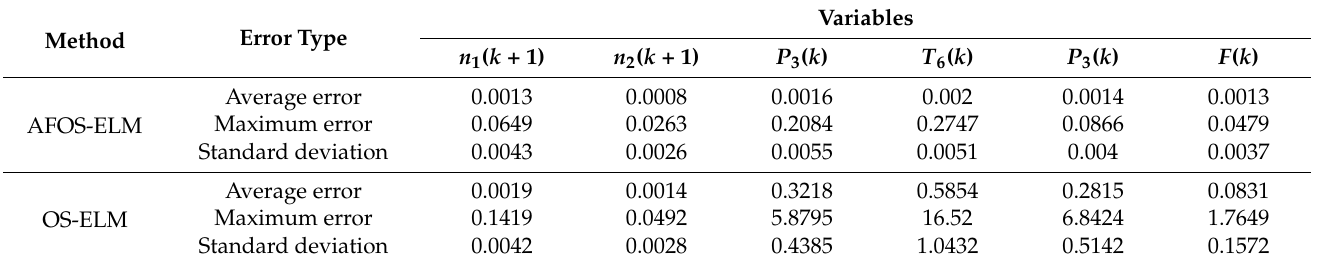
( d ) Figure 4. Comparison of relative error between AFOS-ELM and OS-ELM. ( a ) Error of AFOS-ELM n 2 ( k + 1) output; ( b ) error of OS-ELM n 2 ( k + 1) output; ( c ) error of AFOS-ELM F ( k + 1) output; ( d ) error of OS-ELM F ( k + 1) output.